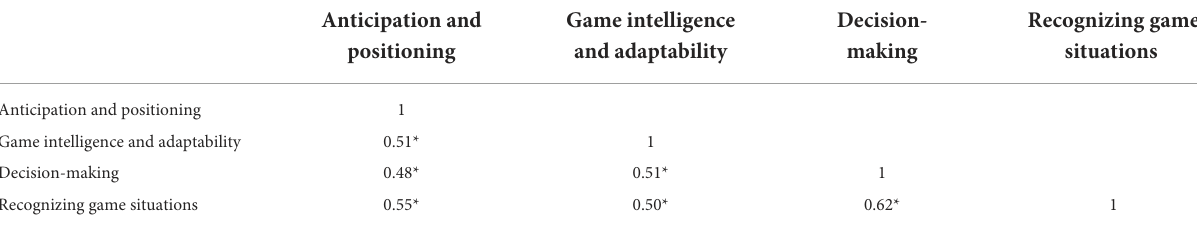
TABLE 3 Pearson correlations between subscales of the